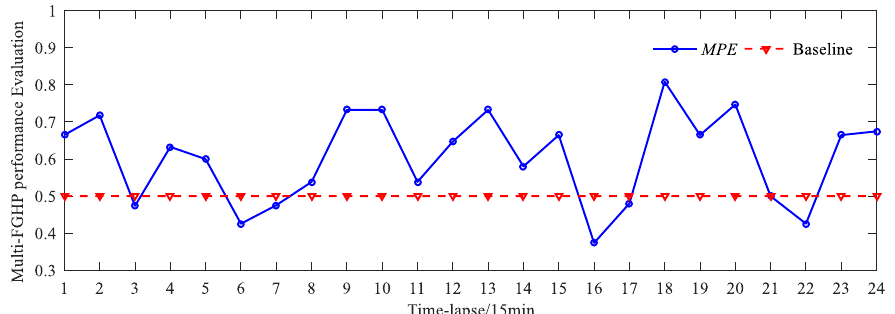
Figure 8. Multi-FGHP performance evaluation fluctuation with time lapse. Table 7. Singularity analysis of multi-FGHP performance evaluation at a fixed time (12:00 – 18:00 on